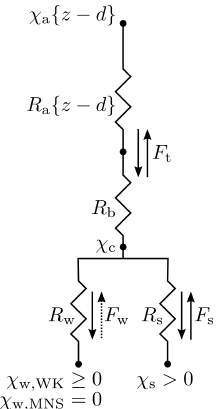
Figure 1. Structure of the single-layer model of NH 3 surface– atmosphere exchange used in this study. The non-stomatal path- way can be treated either uni- or bidirectionally, depending on the specific parameterization. MNS = Massad et al. (2010); WK = Wichink Kruit et al.